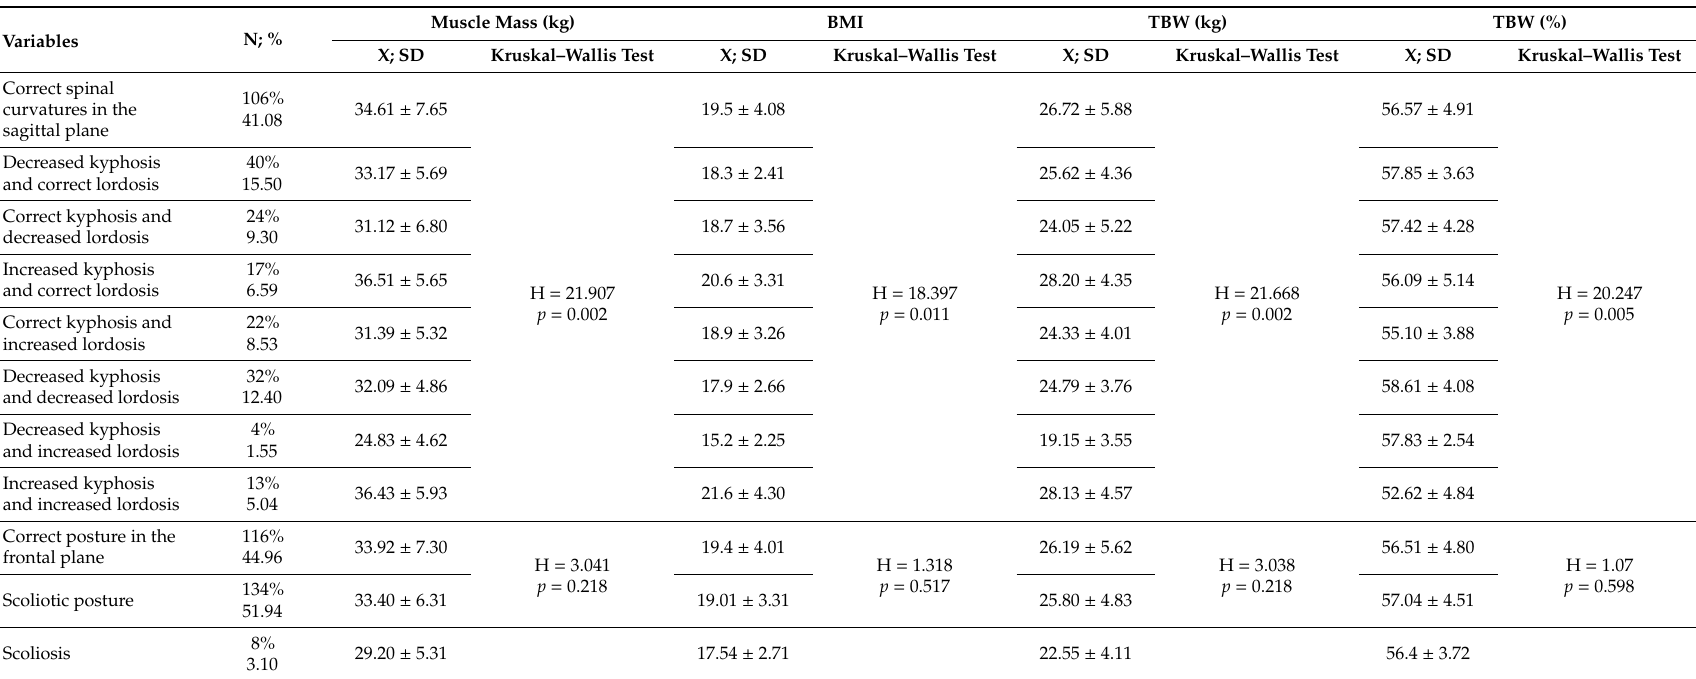
Table 3. Body posture defects according to body